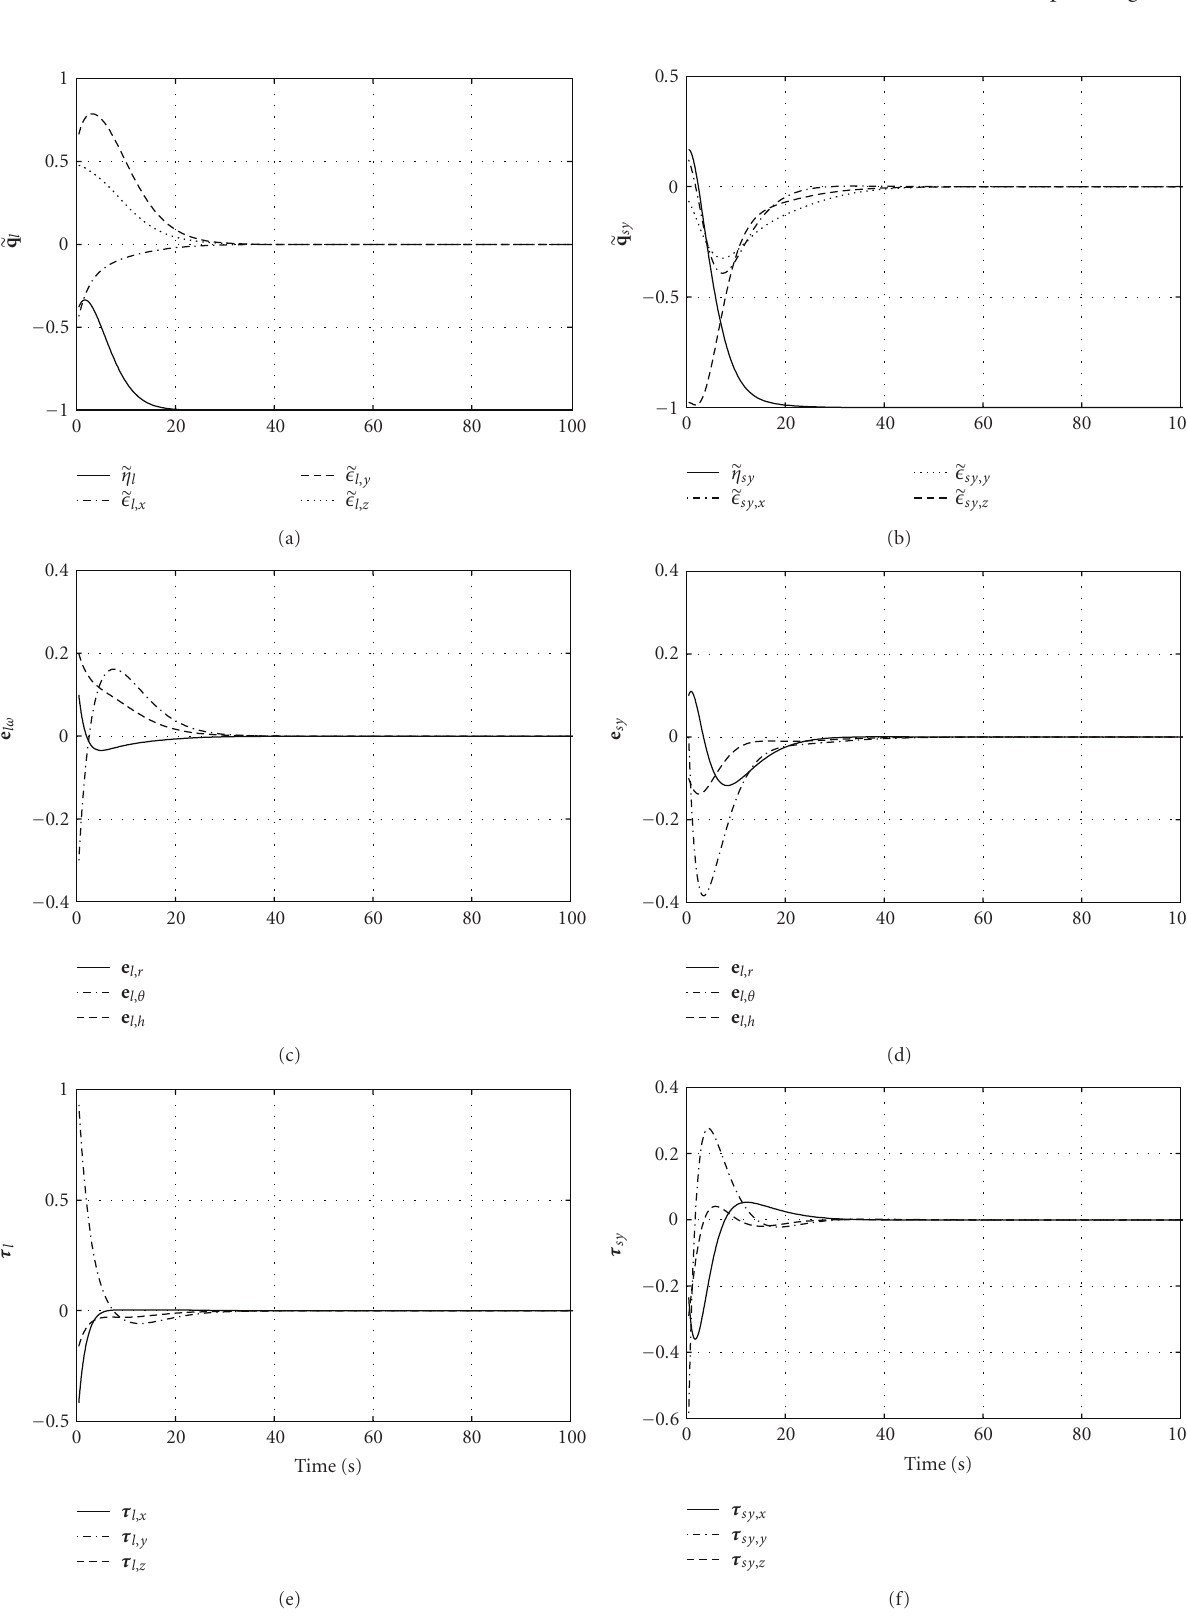
Figure 2: Attitude and angular velocity error and control torque for leader ((a), (c), (e)) and synchronizing follower ((b), (d), (f)) spacecraft during maneuver without measurement noise and